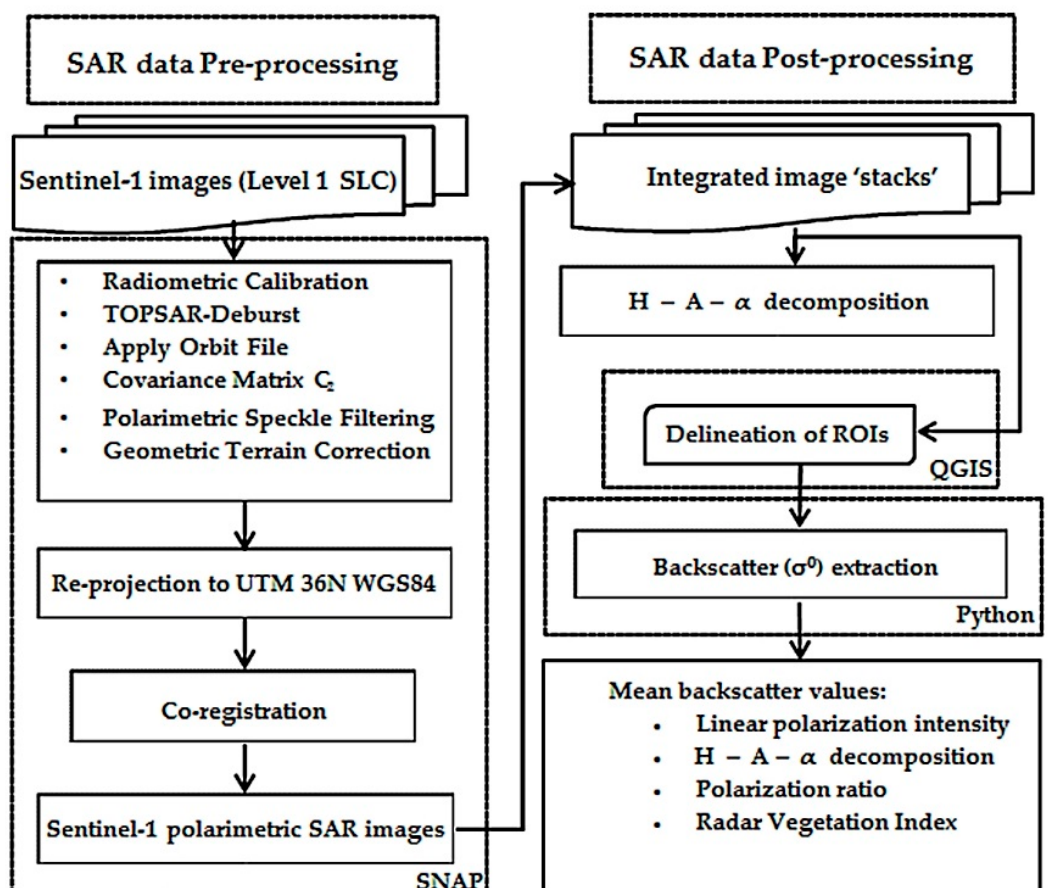
Figure 7. Flowchart of Sentinel-1 dual polarization SAR data processing.